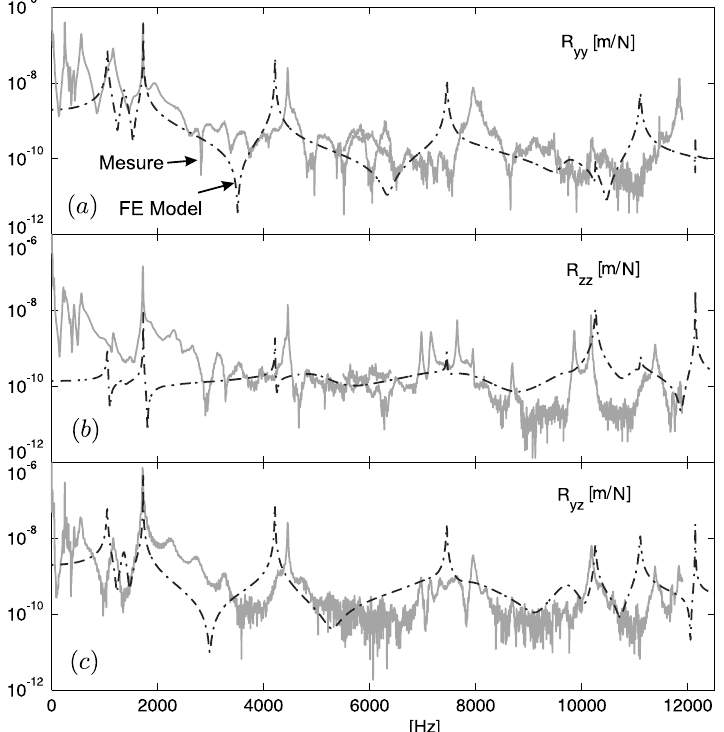
Fig. 5. Dynamics of the wheel: (a) Lateral direct receptance; (b) Vertical direct receptance; (c) Cross receptance between the vertical and the lateral